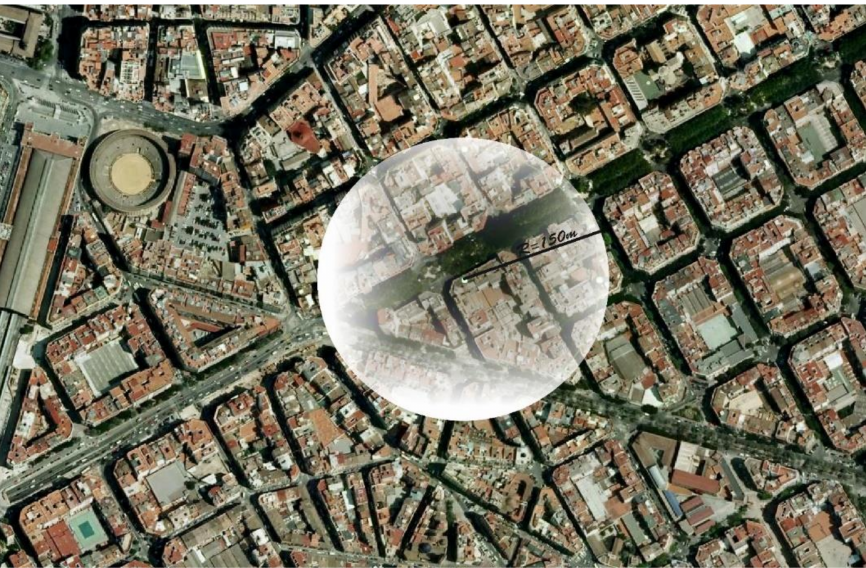
Figure 3. Aerial view of the area around Gran V í a Marqu é s del Turia 12, Valencia. Source: Own elaboration. Each of the 565 sample items was designated to 35 variables related to the type of occupation in each year, the sum of the years occupied, the variation in occupation, the size of said variation, and the type of occupation during the years studied (up to 131 different types of use after simplifying the type of occupation to eliminate spurious differences related to the name of the activity). The variables also included a time series, from 2008 to 2018 (11 years), and variables related to the street environment: type of road (whether open to vehicle traffic or pedestrian only); number of lanes of road traffic (one to four lanes); presence of parking spaces in front of the premises (yes or no); sidewalk dimension (narrow, less than 2 m; normal, between 2 and 5 m; wide, more than 5 m; and squares, open